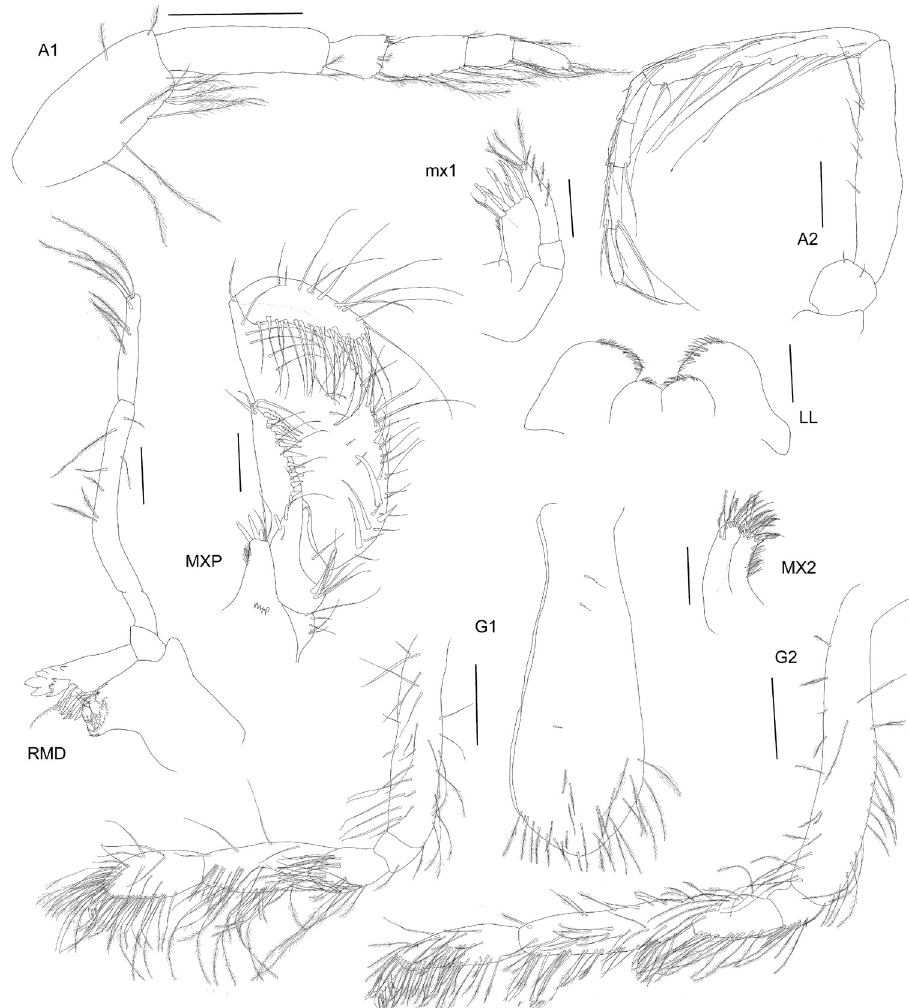
Figure 3. Byblisoides bellansantiniae sp. n. Holotype, female, 14 mm, ZMH K-47035, Irminger Basin, Iceland, 2537.3–2538.1 m. Antennae 1–2, gnathopods 1–2 scales represent 0.5 mm. Mouthparts scales represent 0.2